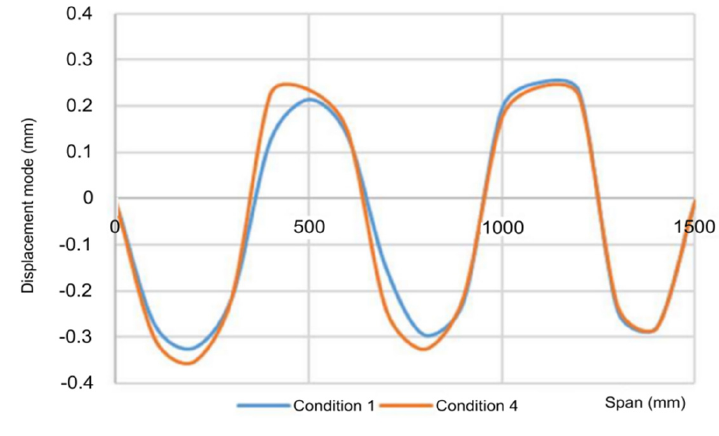
( e ) Comparison of the fifth-order vibration modes under Conditions 1 and 4. Figure 11. Comparison of the first five orders of vibration modes under Conditions 1 and 4. The comparison results of displacement modes under Condition 5 (stiffened and nondamaged) and Condition 6 (stiffened and midspan damage) are shown in Figure 12.